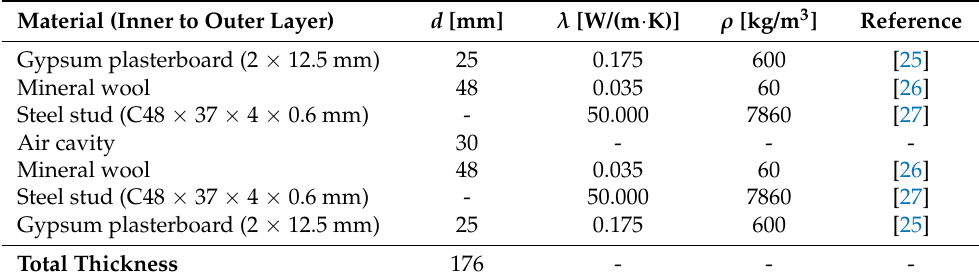
Table 1. Reference double-pane LSF wall materials, thickness (d), and thermal conductivities ( λ ).